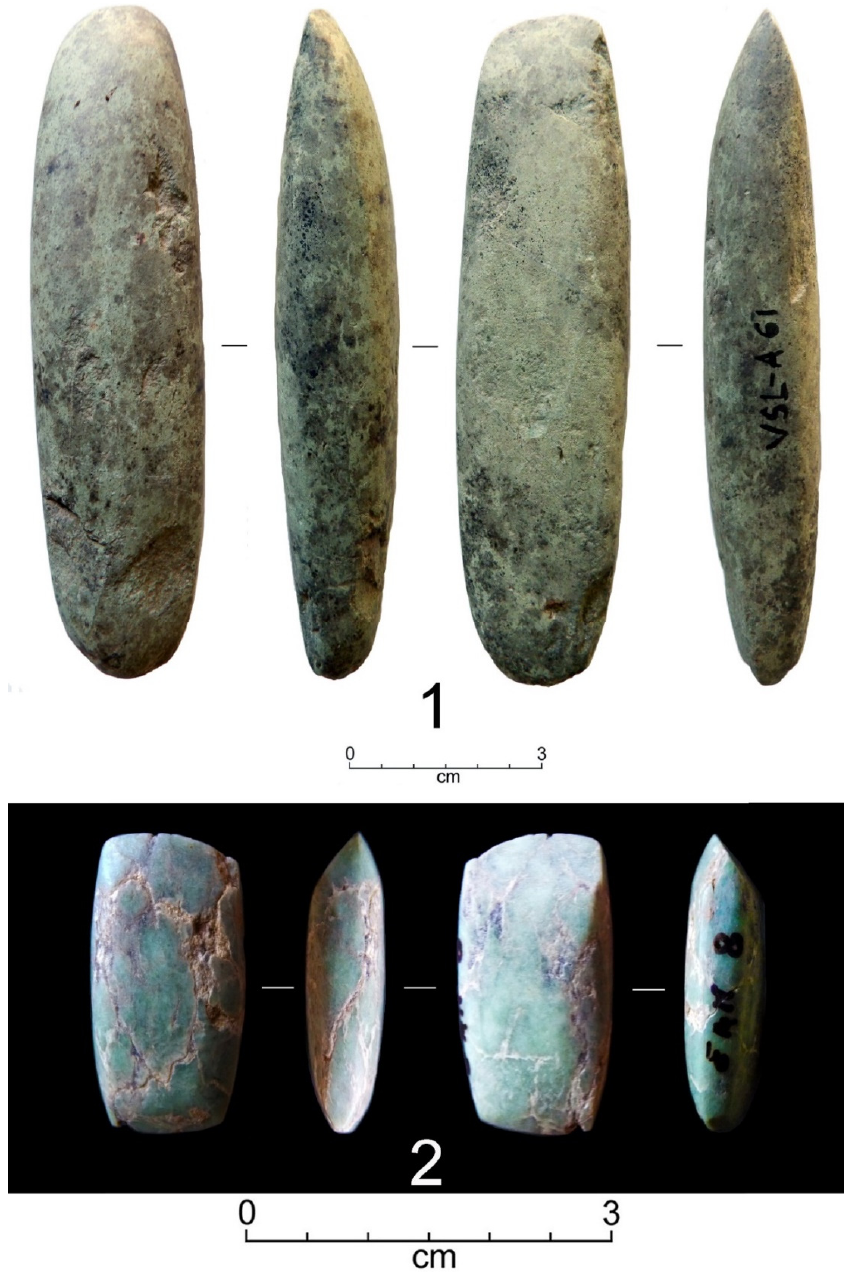
Figure 9. Polished greenstone chisels from Mount Vasilitsa (VSLA-61: n. 1) and Sam-8 (n. 2) (photographs by E. Starnini).